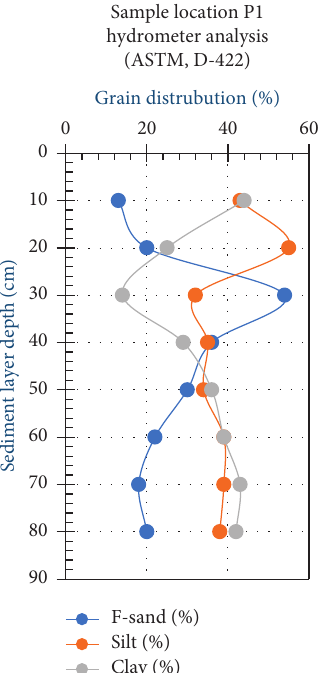
Figure 6: Hydrometer analysis ratio of the sediment soil types along with the core depth.